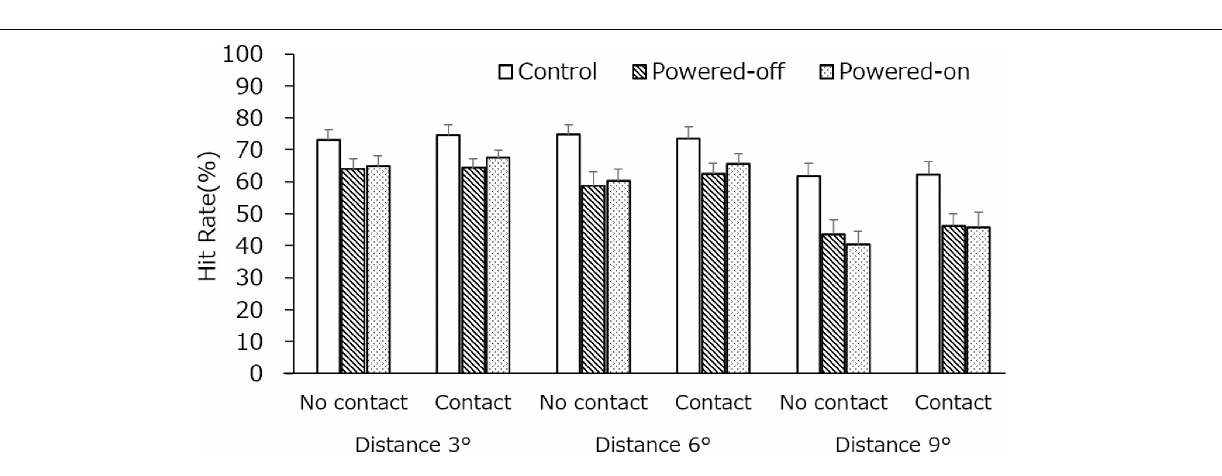
FIGURE 6 | The reaction time (left) and accuracy (right) of the letter recognition task in experiment 2. Error bars depict standard error values.